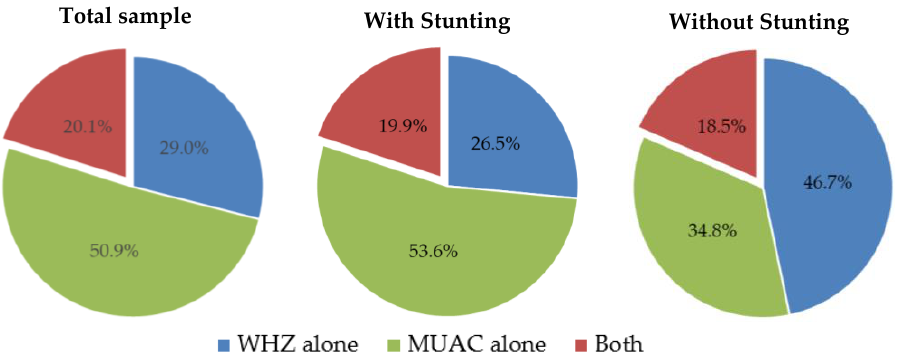
Figure 1. Proportion of wasting diagnosed by weight-for-height (WHZ) and/or mid-upper arm circumference (MUAC) as a function of stunting.